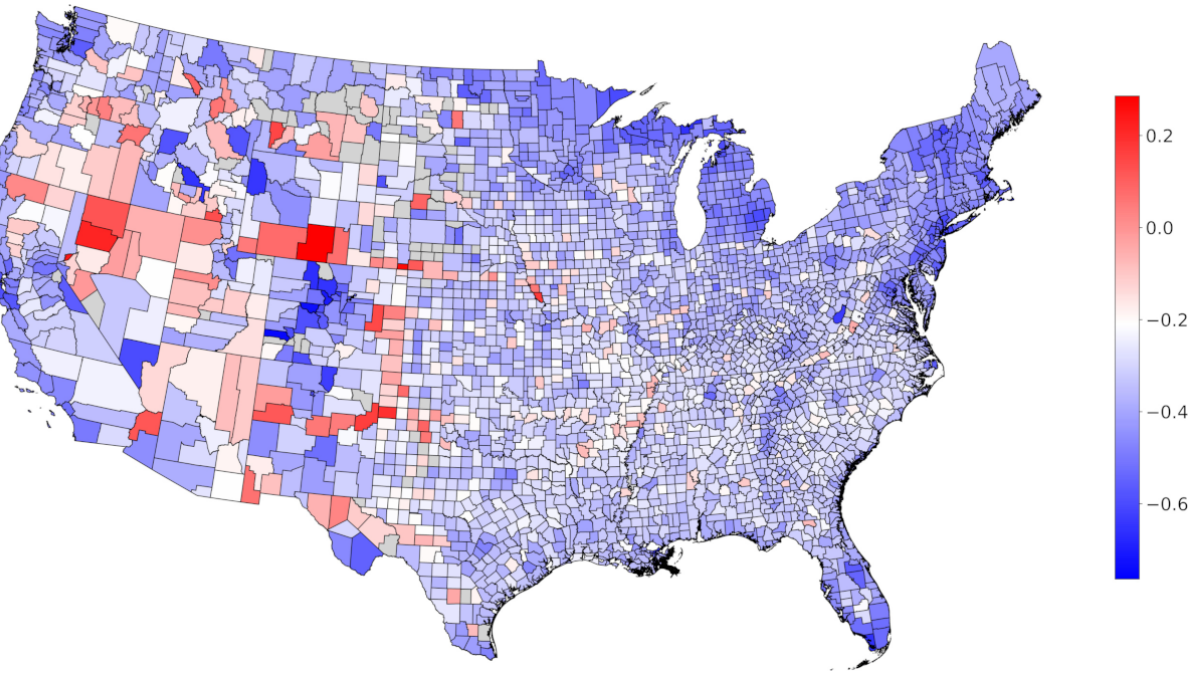
Figure 2. Heterogeneity in mobility during social distancing. The map shows the average mobility during social distancing due to COVID-19 at the county level in the continental United States relative to the pre–COVID-19 baseline. A positive value indicates an increase in distance traveled, and a negative value indicates a decrease in distance traveled. Counties for which data are not available are shown in grey. The color map is centered at the 90% percentile of the decrease in mobility.